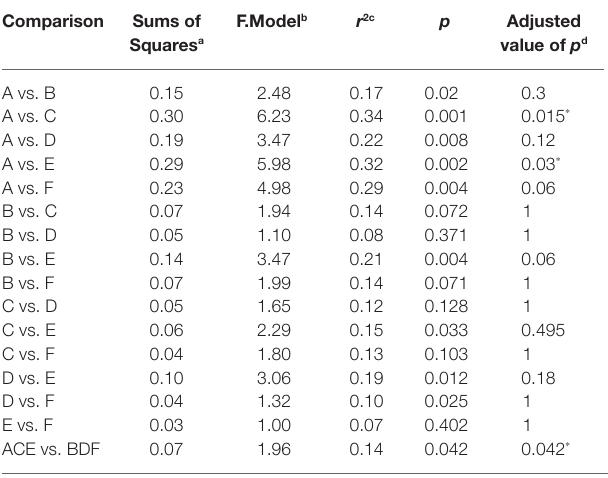
* Indicates a significant difference. a Sums of Squares expresses the total variation. b F.Model expresses the variation between the two cheeses compared. c r 2 , coefficient of determination. d Adjusted value of p, the value of p obtained using Bonferroni